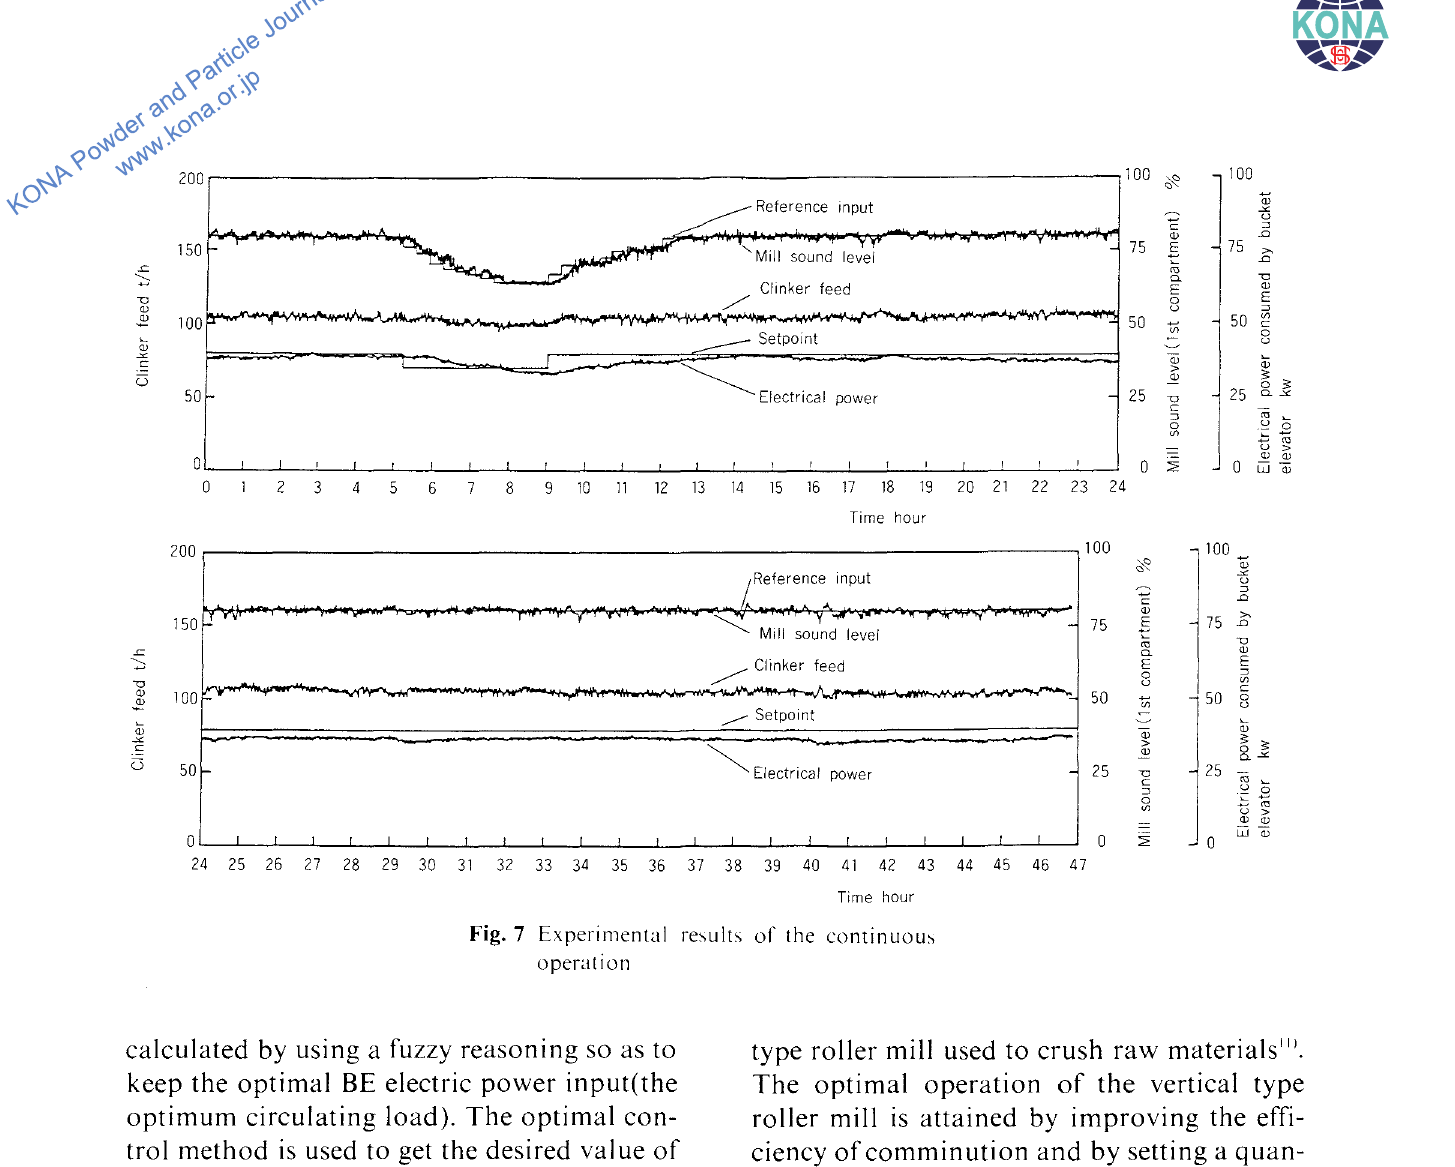
Fig. 7 Experimental re-,ults of the continuou-,